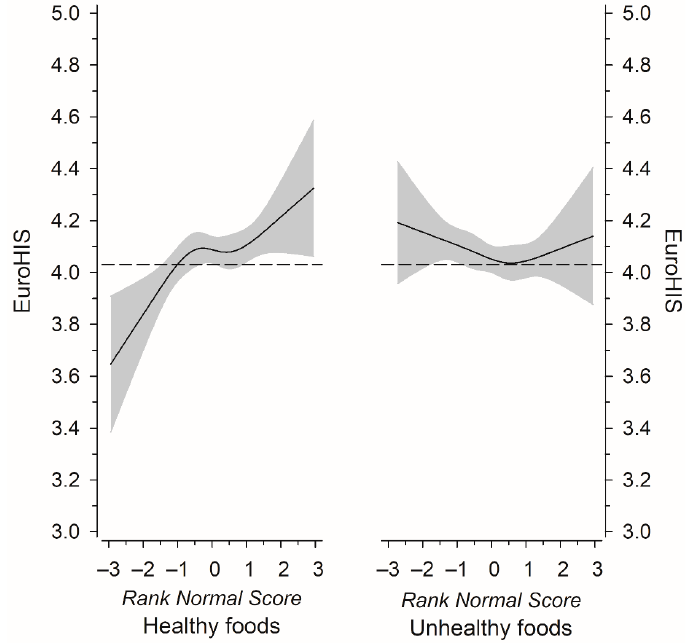
Figure 2. Relationships of EUROHIS-QOL 8-item Index mean as the function of rank-based normal scores of the consumption frequencies of healthy and unhealthy foods. The curves were derived from four-knot restricted cubic splines regression models. The models were adjusted for age, body mass index, education years, number of chronic diseases, smoking, and physical activity. Gray areas represent 95% confidence intervals.